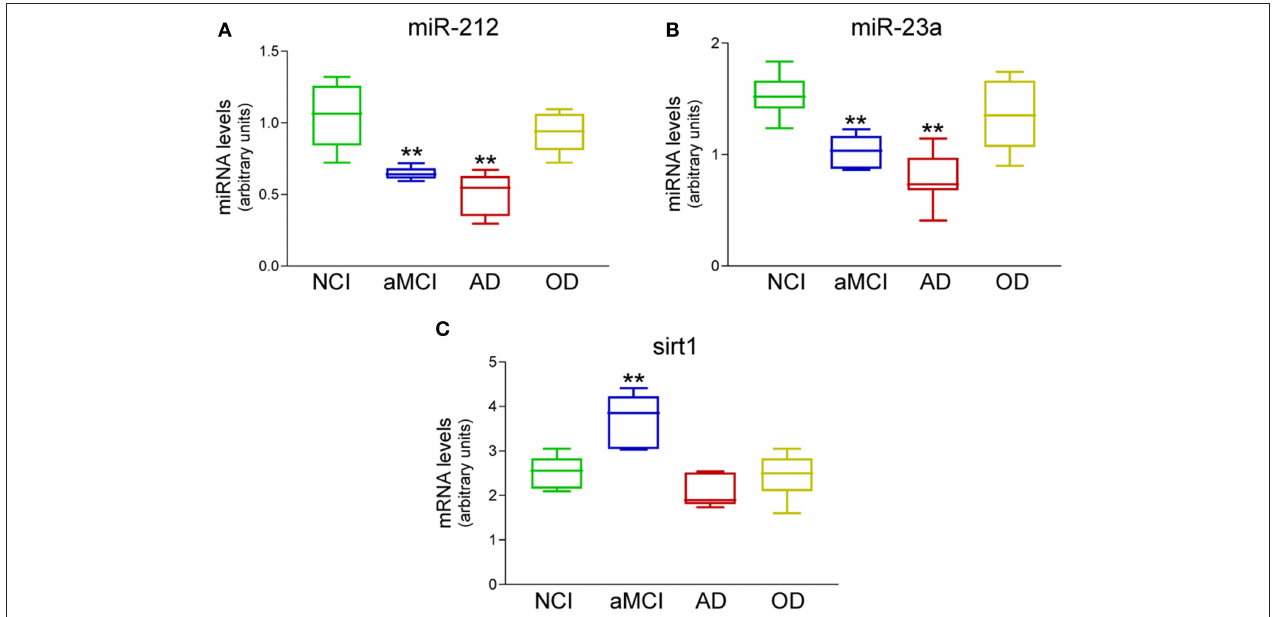
FIGURE 1 | Differential expression of miR-212, miR-23a, and sirt1 transcripts in the frontal cortex of aMCI subjects. qPCR analysis was performed on frozen frontal cortex tissue samples harvested from NCI ( n = 12 ), aMCI ( n = 10 ), mild AD ( n = 10 ), and other dementia (OD, n = 5 ) neurologic control subjects. Box plots show that (A) miR-212 and (B) miR-23a were significantly down-regulated by ∼ 50% in aMCI and by ∼ 60% in AD. (C) Their predicted mRNA target sirt1 was up-regulated by ∼ 40% in aMCI. miR expression levels were normalized to the human RNU48 control miRNA, whereas sirt1 mRNA was normalized to GAPDH for quantitative analysis. ** p < 0.01 via One-way ANOVA with Bonferroni correction for multiple comparisons.